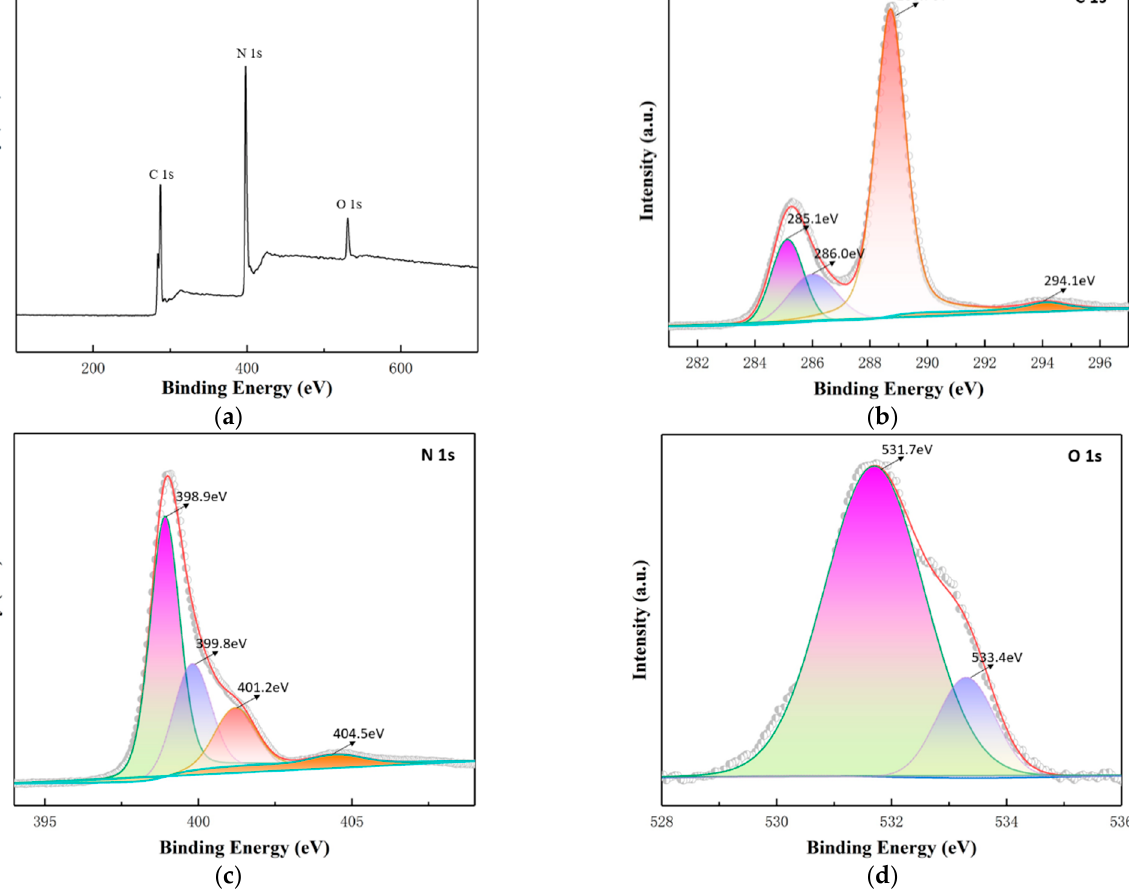
Figure 6. XPS survey spectrum of g-C 3 N 4 /CQDs composites: ( a ) the full − scale XPS spectrum, high − resolution XPS spectra of ( b ) C 1s, ( c ) N 1s, ( d ) O 1s.